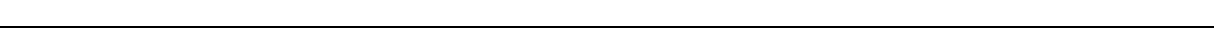
Fig. 2 miR-29-mediated reduction of H4K20me3 leads to premature cellular senescence. a , b Luciferase assays with the wild-type Suv4-20h1 3 ′ UTR or mutated Suv4-20h1 3 ′ UTR ( a ), as well as with the wild-type Suv4-20h2 3 ′ UTR or mutated Suv4-20h2 3 ′ UTR ( b ) in the predicted binding site of miR-29a, miR-29b and miR-29c, transfected with control miRNA mimics (M-miR-Ctrl) or miR-29 mimics (M-miR-29a, M-miR-29b and M-miR-29c). c Protein levels of H4K20 were measured by western blotting in MEFs transfected with M-miR-29 or miR-29 inhibitors (I-miR-29a and I-miR-29c). β -actin served as a loading control. d Western blot for global H4K20 methylation in cells with lentivirus-mediated ectopic expression of the indicated miR-29. β -actin served as a loading control. e SA- β -gal staining and diagrams showing MEFs from PD4 transfected with M-miR-29 and MEFs from PD8 transfected with I-miR-29. Scale bar, 20 μ m. One-way ANOVA with Dunnett ’ s multiple comparison test was performed. f , g Immuno fl uorescent staining of Mki67 in MEFs transfected with M-miR-29 ( f ) or I-miR-29 ( g ). Scale bar, 5 μ m. h Cells were fi rst transfected with M-miR-Ctrl, M-miR-29a or M-miR-29c, after which they were infected with pBabe, pBabe-Suv4-20h1 or pBabe-Suv4-20h2 and subjected to western blotting for the indicated protein. β -actin served as a loading control. i SA- β -gal staining analysis was performed as described for cells in h . Scale bar, 20 μ m. j Immuno fl uorescent staining of Mki67 in the cells from i . Scale bar, 5 μ m. The error bars show the s.d obtained from triplicate independent experiments. Two-tailed unpaired Student ’ s t -tests were performed, ** p < 0.01, *** p <